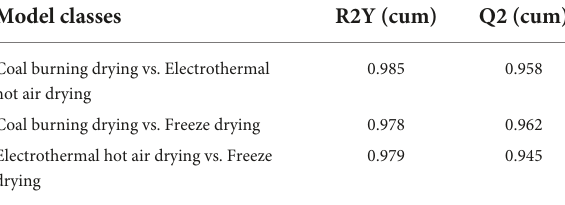
TABLE 1 The detailed comparison of OPLS-DA models and parameters among three drying methods. Model